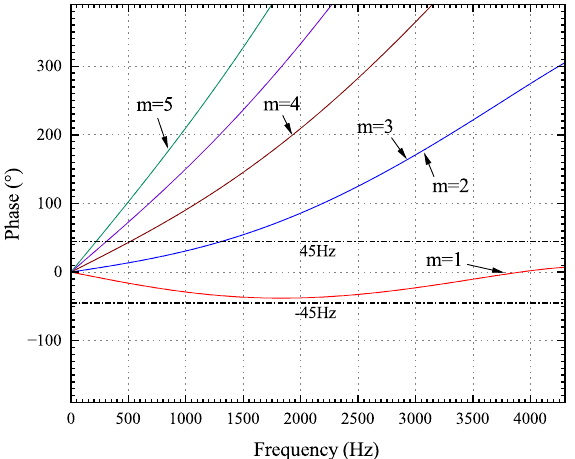
Figure 10. The phase response of G p ( z ) z m